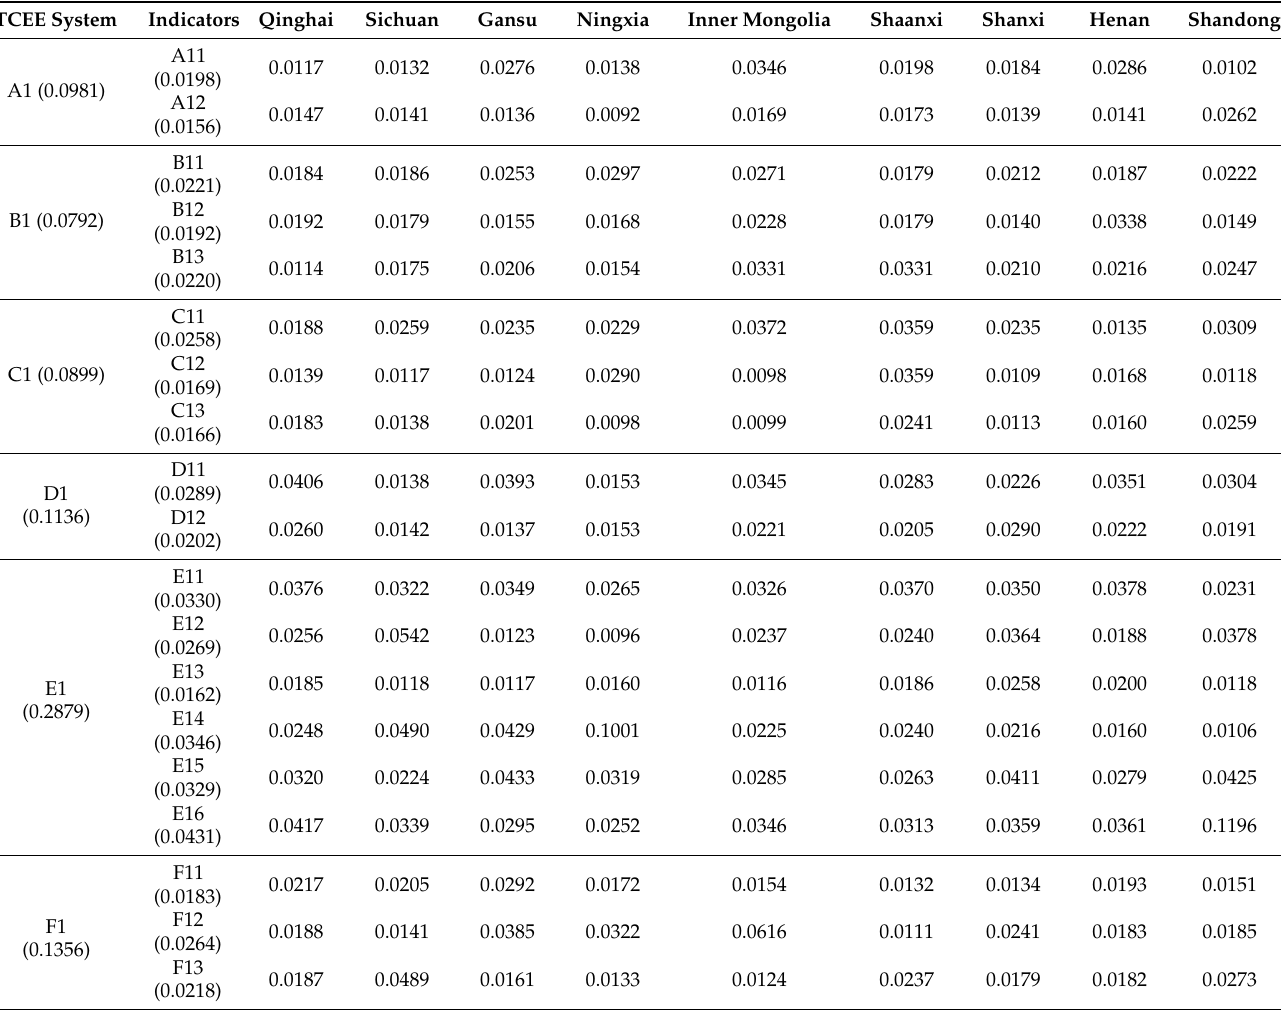
Table 4. Weight of tourism’s carbon emission efficiency (TCEE) evaluation index of the nine provinces in the Yellow River